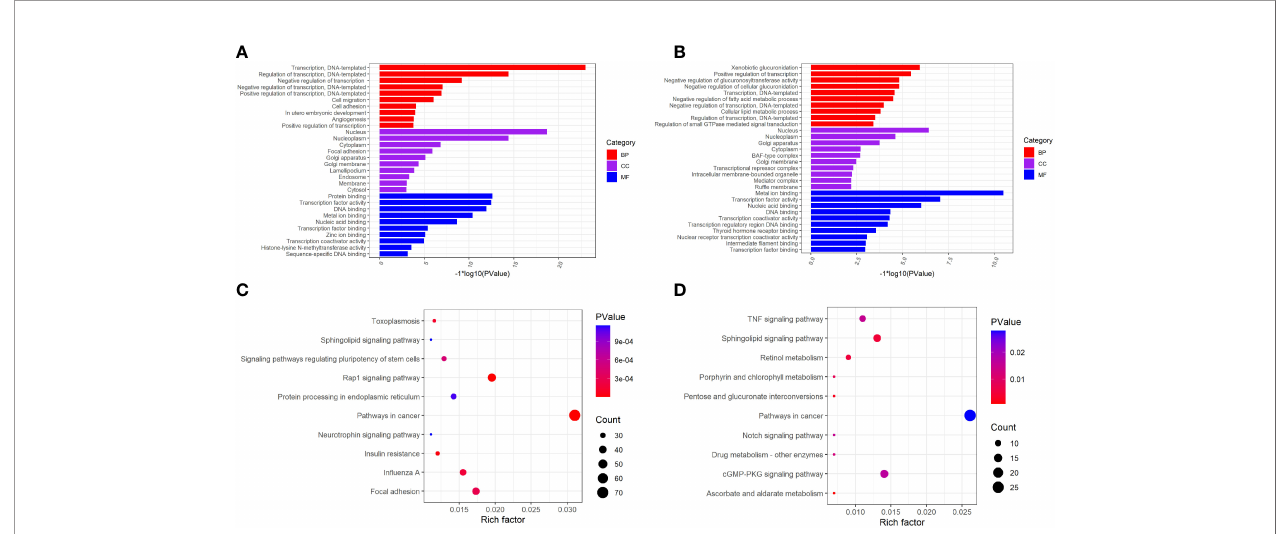
FIGURE 2 | GO function and KEGG pathway enrichment of differently methylated m6A genes. (A) The top 10 GO terms of genes with down-regulated m6A peaks. (B) The top 10 GO terms of genes with up-regulated m6A peaks. (C) The top 10 KEGG pathways of genes with down-regulated m6A peaks. (D) The top 10 KEGG pathways of genes with up-regulated m6A